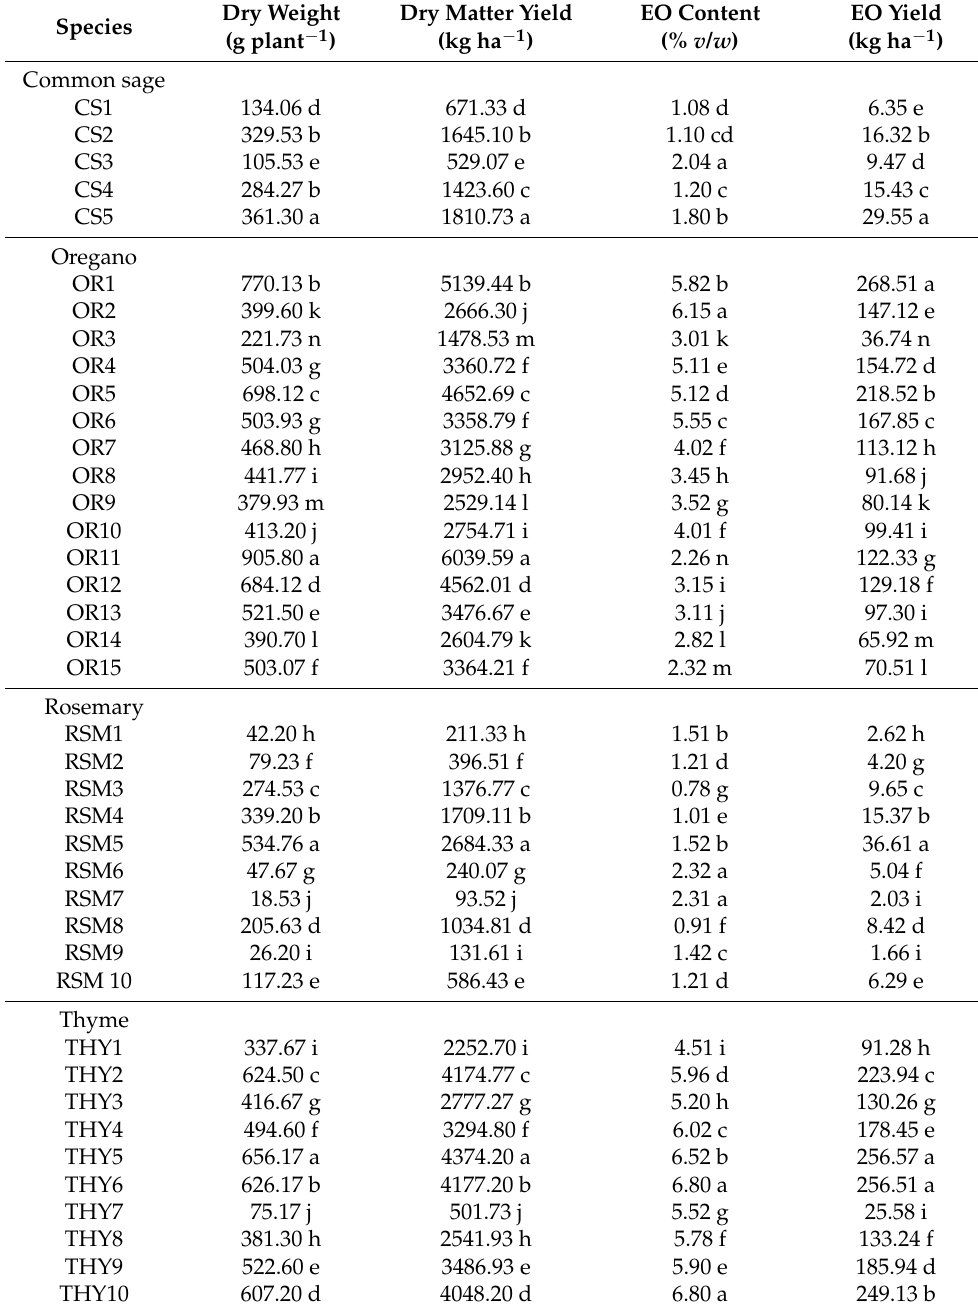
Table 2. Production characteristics of the four MAPs during the study